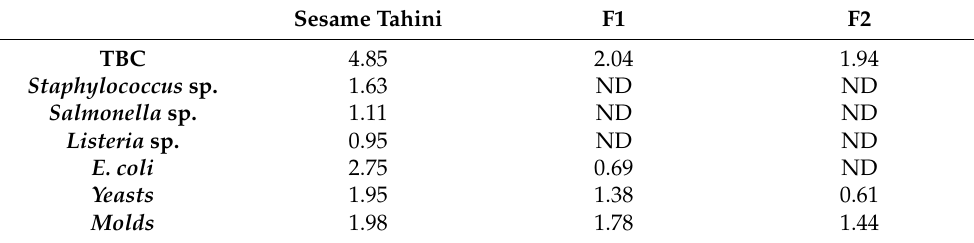
Table 4. Microbiological changes in the tahini model after fortification by Agaricus blazei (logcfu/g).